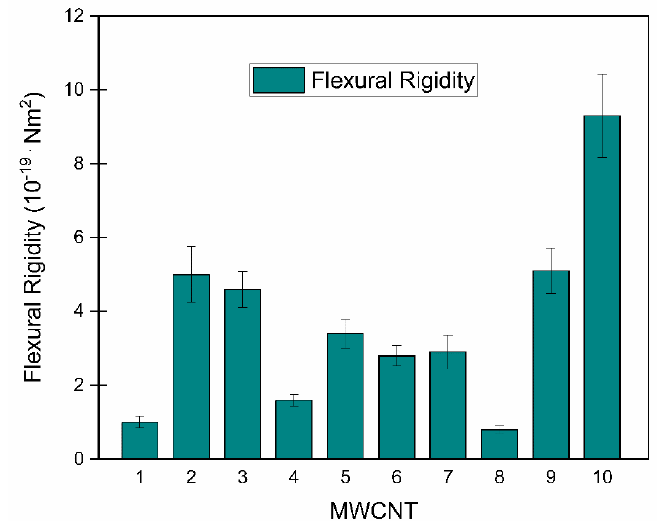
Figure 10. Representation of the flexural rigidity of the ten MWCNTs studied, from the thinnest to the thickest nanotube. Table 3. Finite elements simulation values of resonance frequencies at first and second mode for a CNT with no imperfections, with a mass in the middle of the body and with a mass at the tip. The percentage values are compared to the frequencies of a CNT with no extra mass.